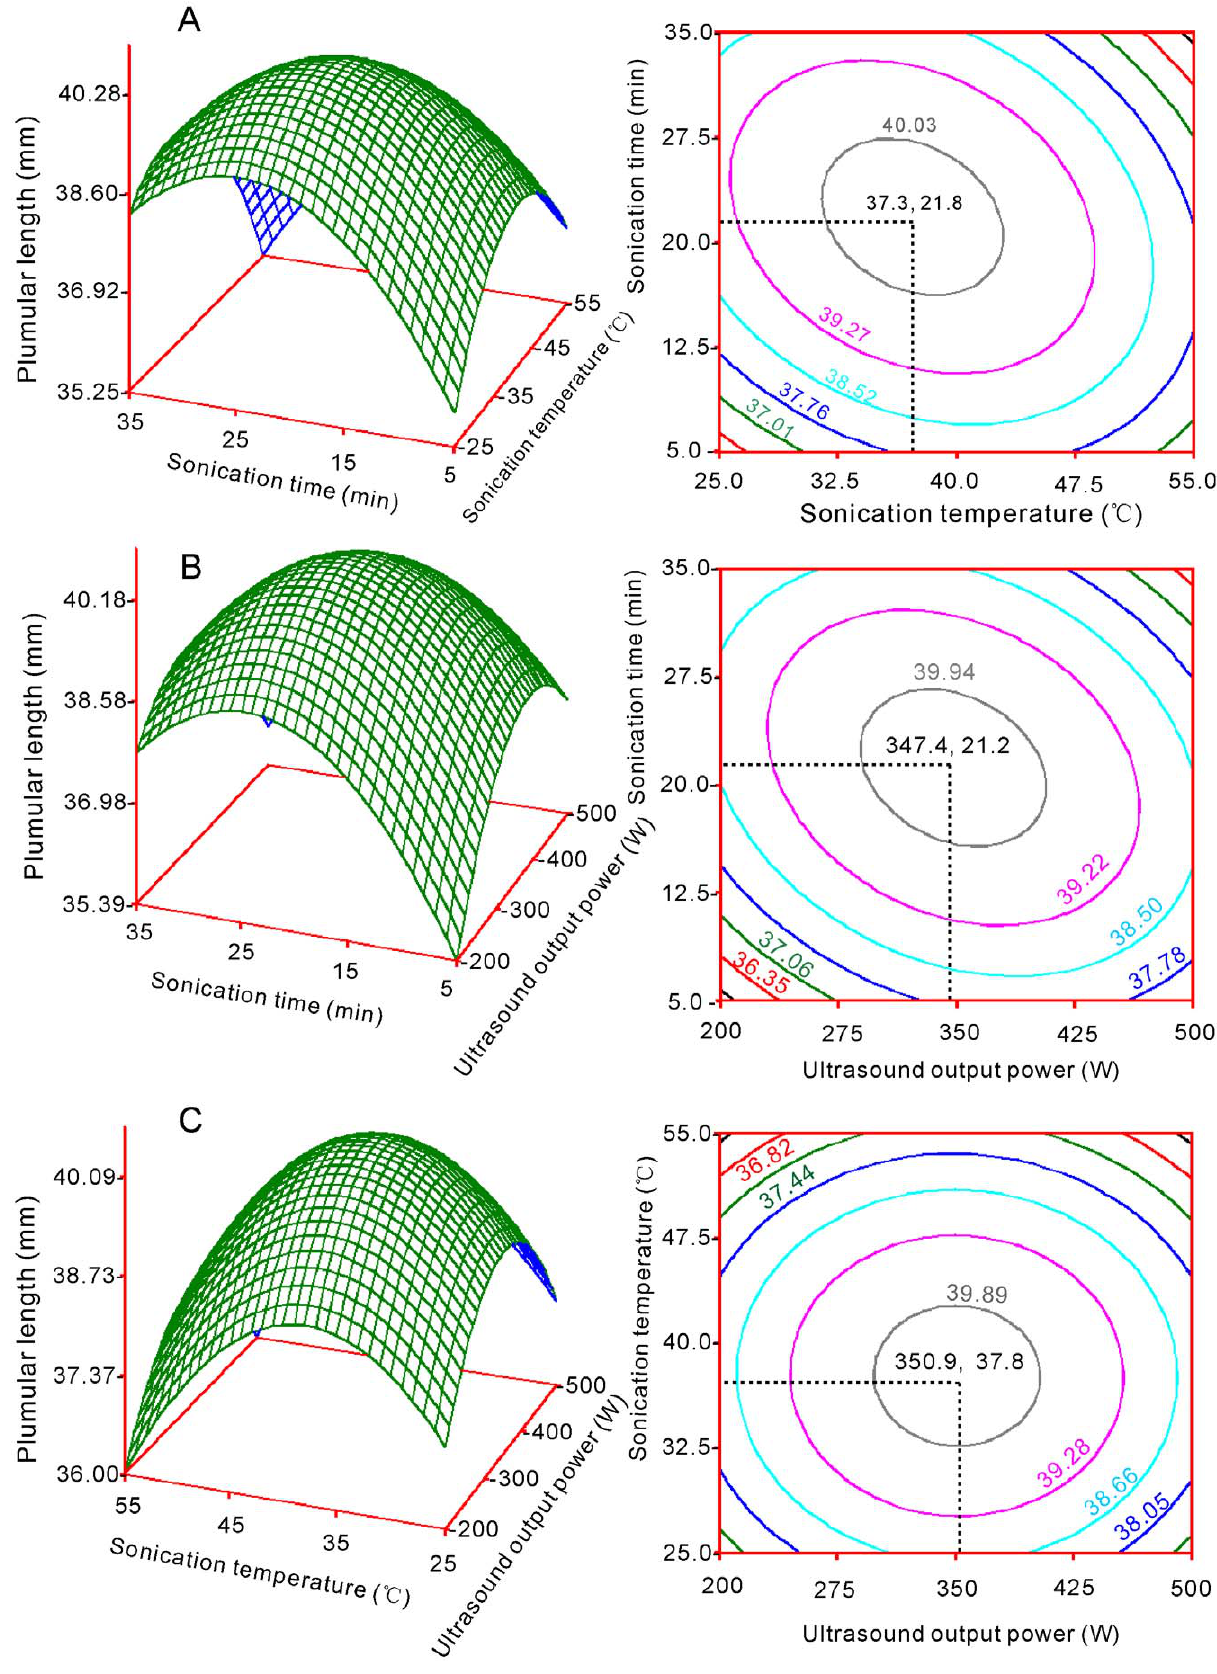
Figure 2. Response surface plots showing the parameter effects on the plumular length in switchgrass by ultrasound irradiation. (a) Plumular length vs. sonication time and sonication temperature; (b) Plumular length vs. sonication time and ultrasound output power; (c) Plumular length vs. sonication temperature and ultrasound output power. doi:10.1371/journal.pone.0047204.g002 PLOS ONE |